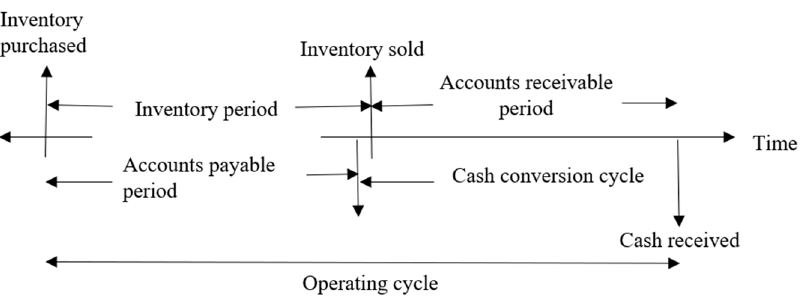
Figure 2. Relationship between cash flow and business cycle as per Richards and Laughlin (1980).